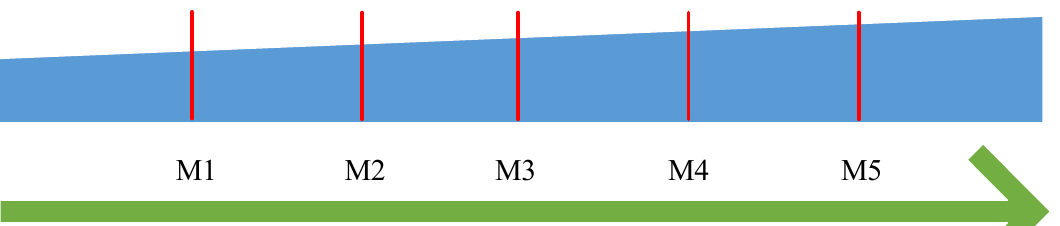
Figure 8. Trainset accumulated mileage factor.